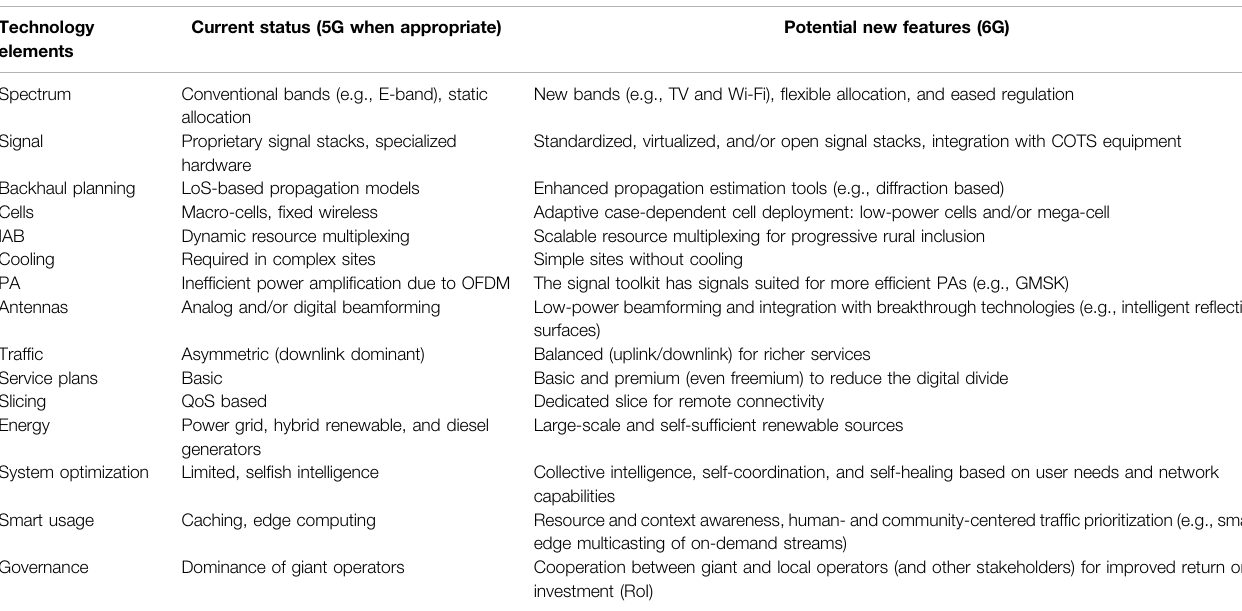
TABLE 6 | Evolution of terrestrial wireless backhauling in remote areas from 5G to